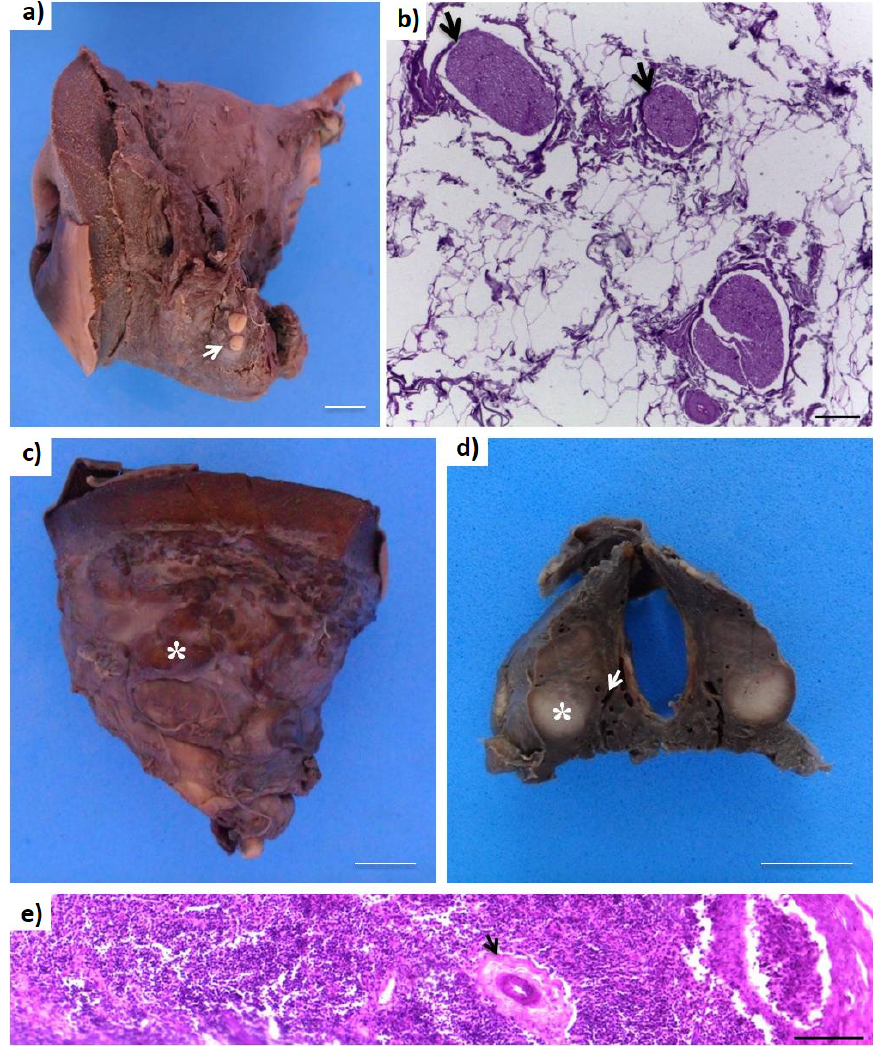
Figure 2. a) and b) Medial view of the nerves (arrows) located in the ventromedial region of the lower palpebra of Sotalia guianensis . Bars: 1.9 cm and 100 μm. c), d) and e) Dorsal view of the lymphoid